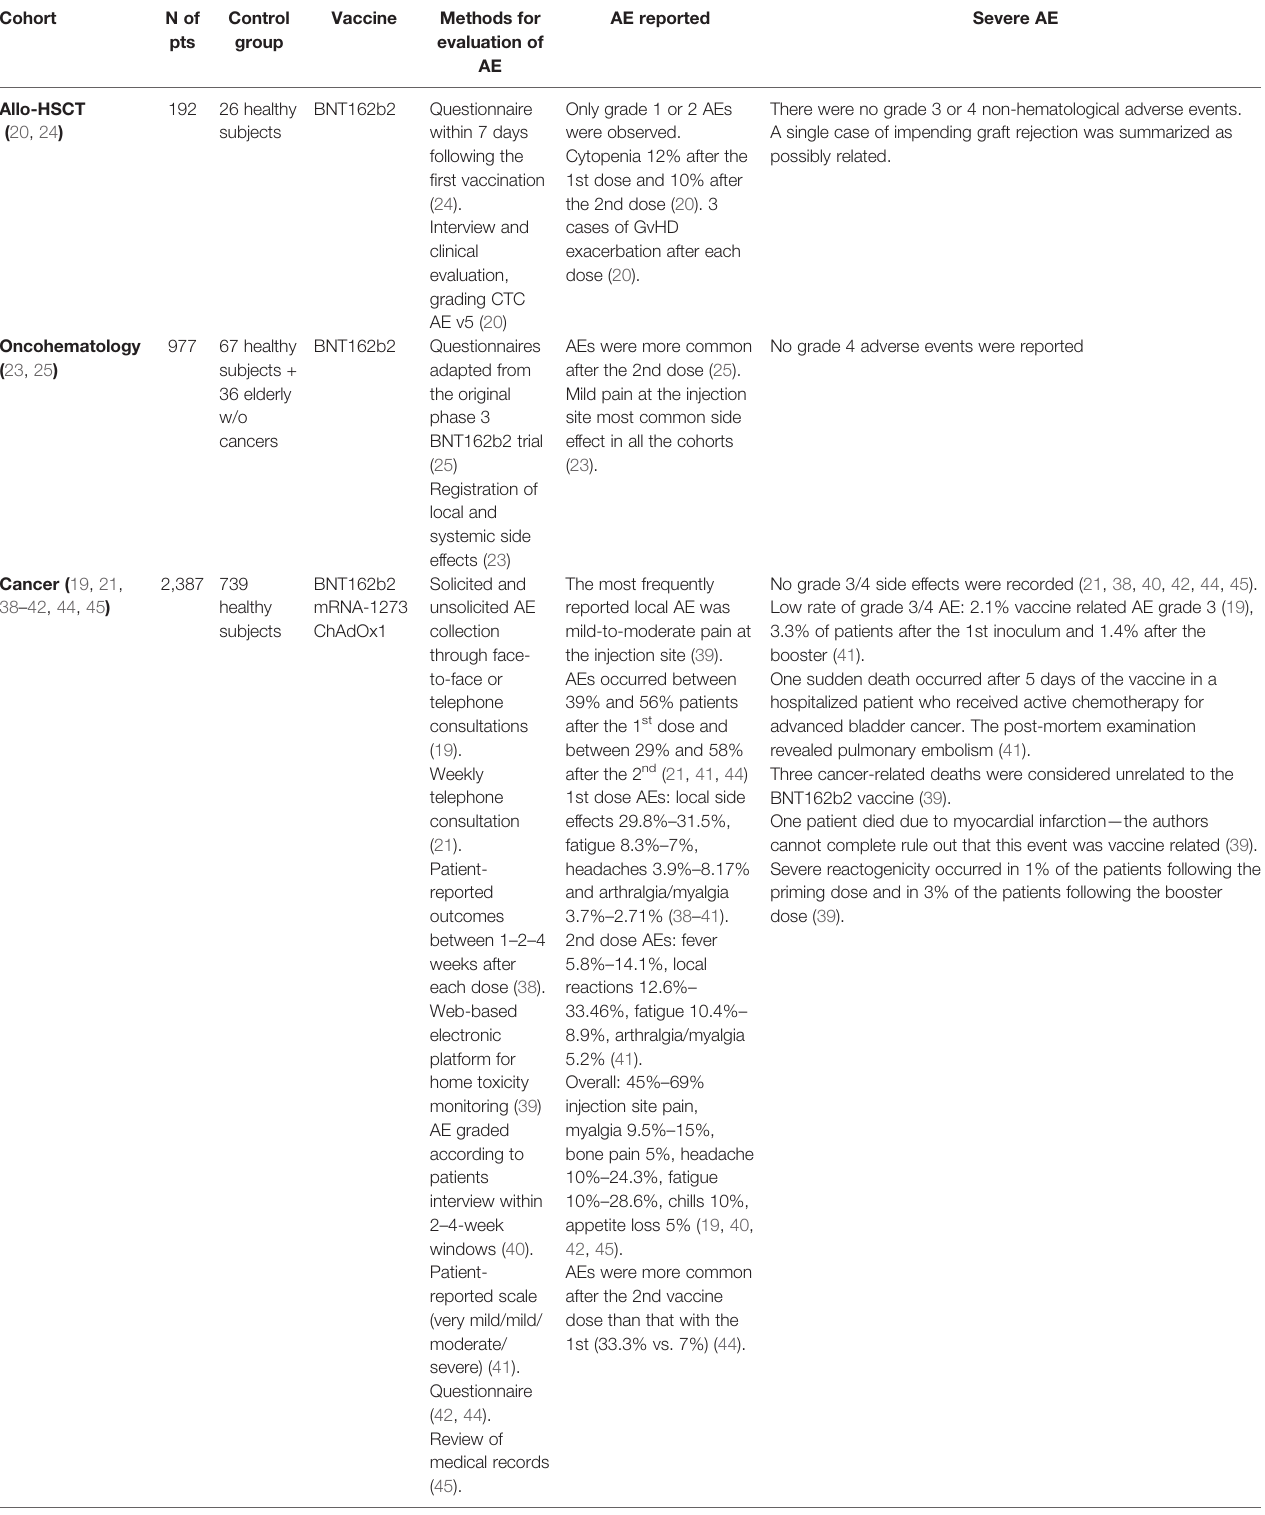
TABLE 4 | Literature